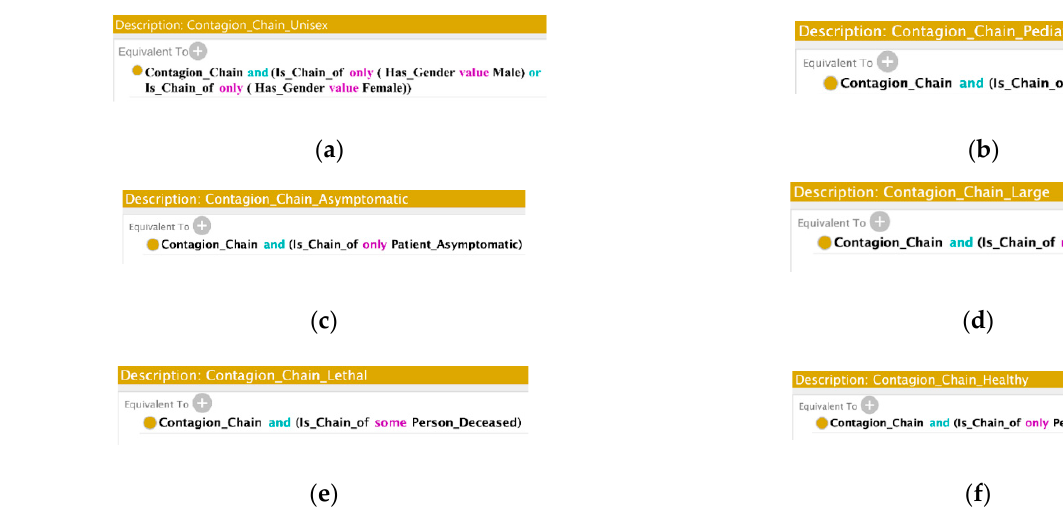
Figure 3. Definition of different types of Contagion_Chain : ( a ) Contagion_Chain_Unisex ; ( b )